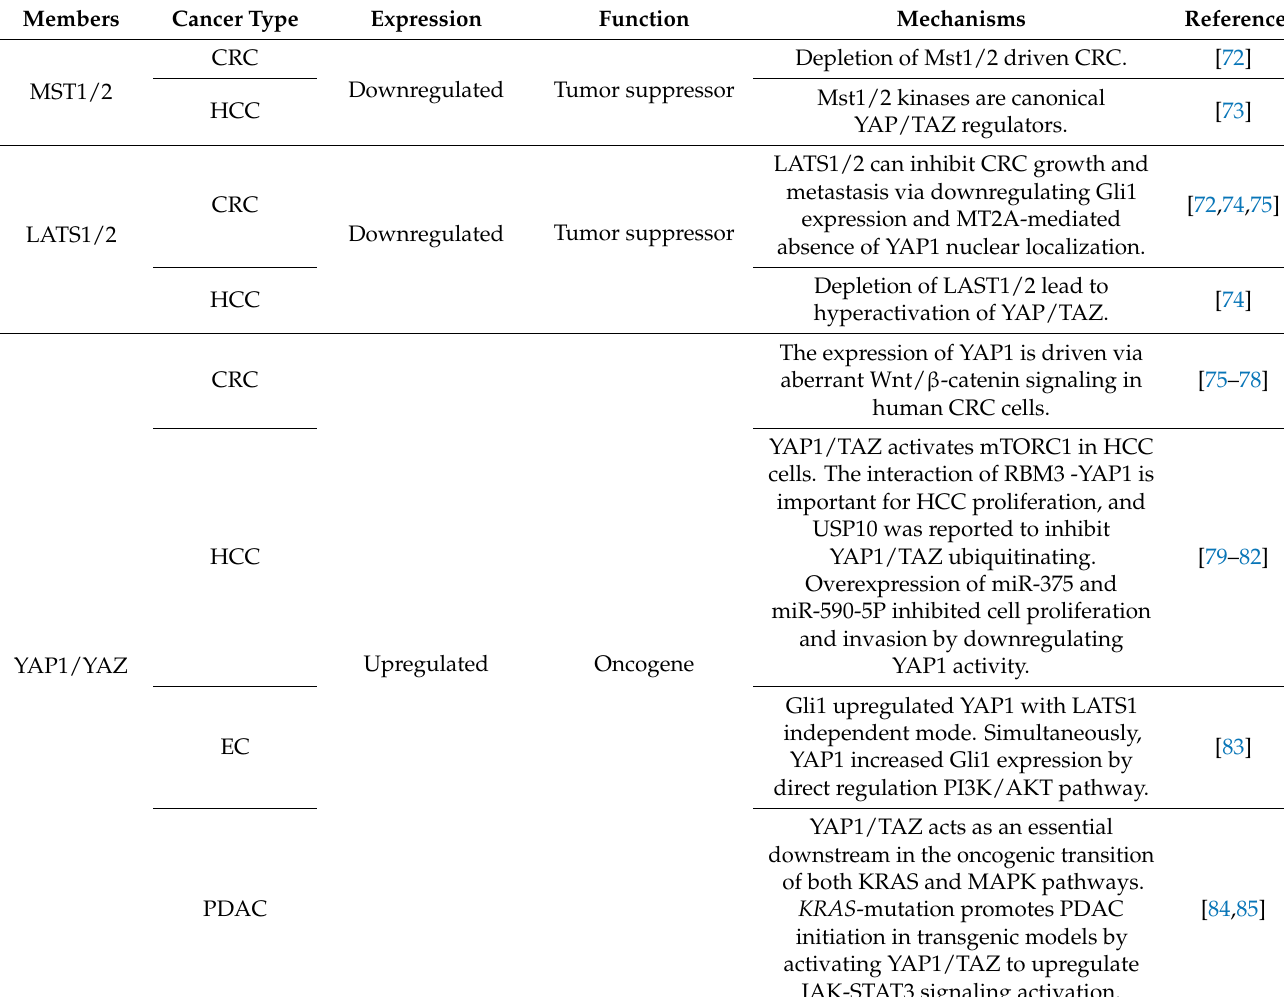
Table 2. Summary of the main Hippo signaling pathway core components in GI